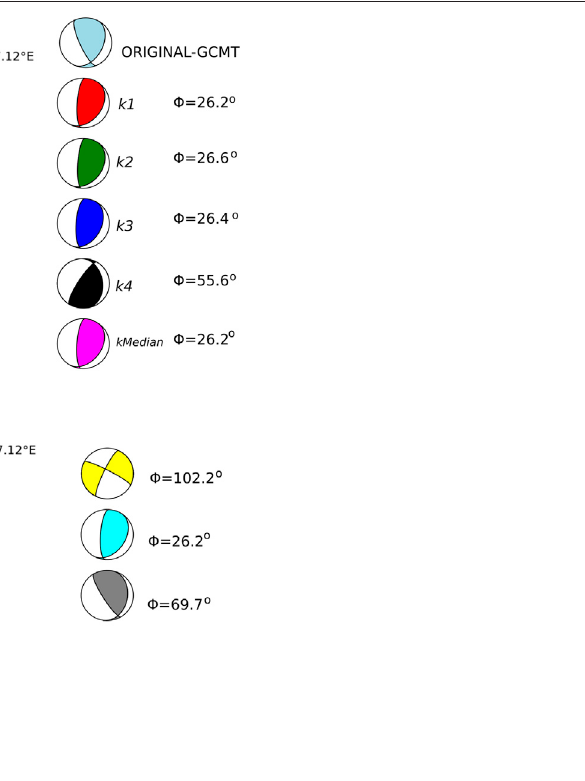
ellipse in Figure 4 .